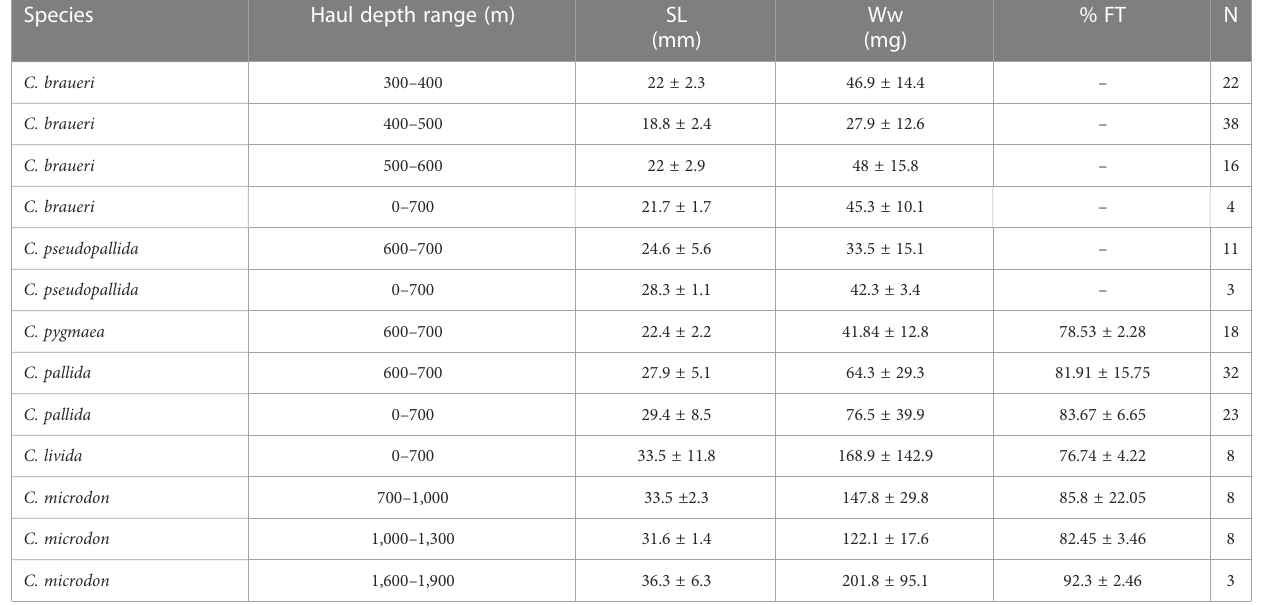
TABLE 2 Summary of Cyclothone spp. examined with histology. Species